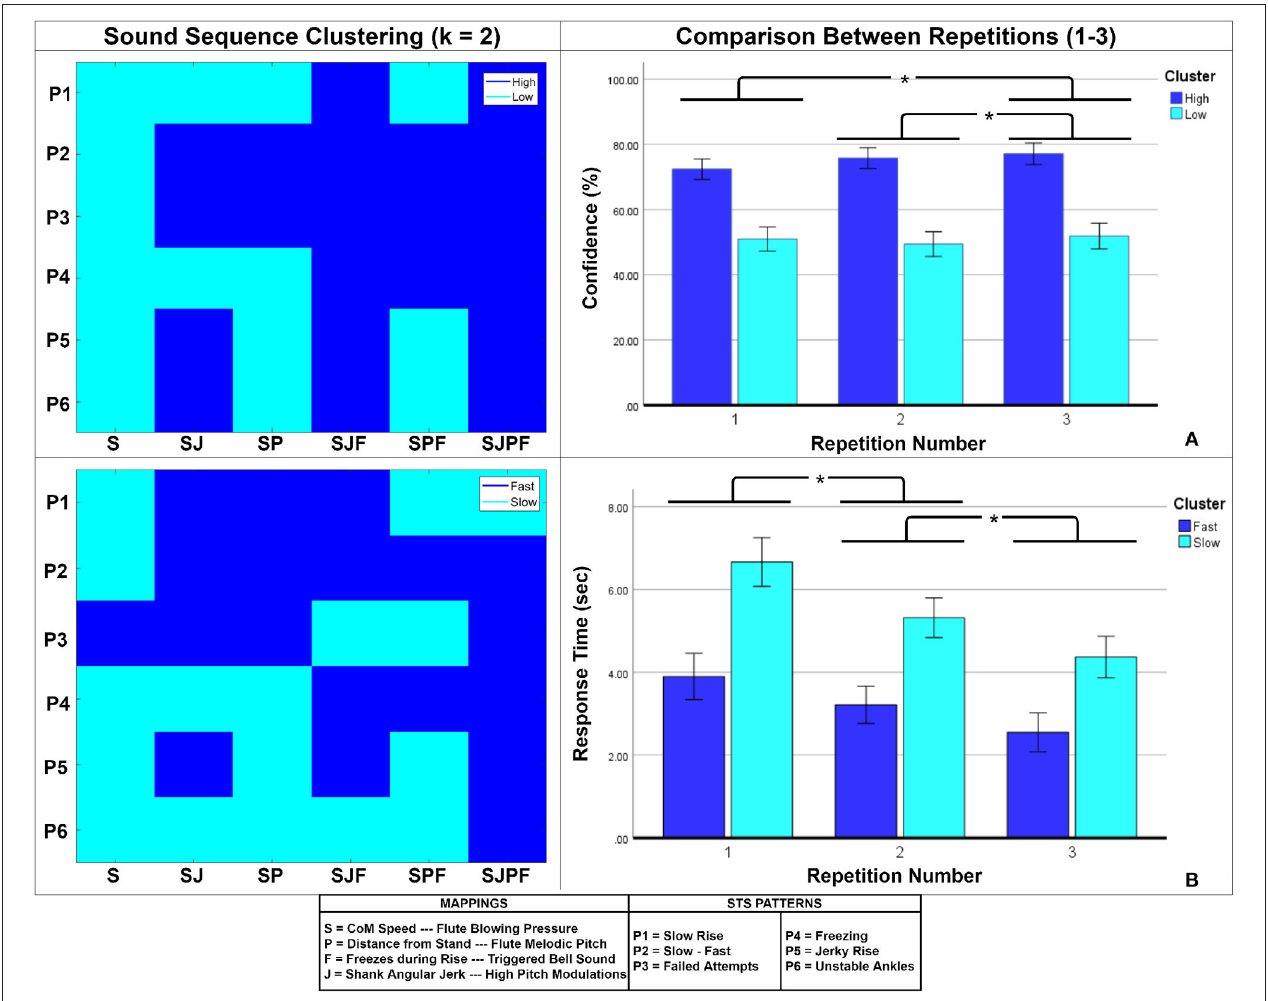
FIGURE 5 | (A) Confidence-based clustering, (B) Response Time-based clustering of sound sequences. The clusters are shown on the left, and the comparison between repetition numbers is shown on the right. Bar heights indicate mean values, and the error bars show 95% confidence intervals. Asterisks indicate significant pairwise